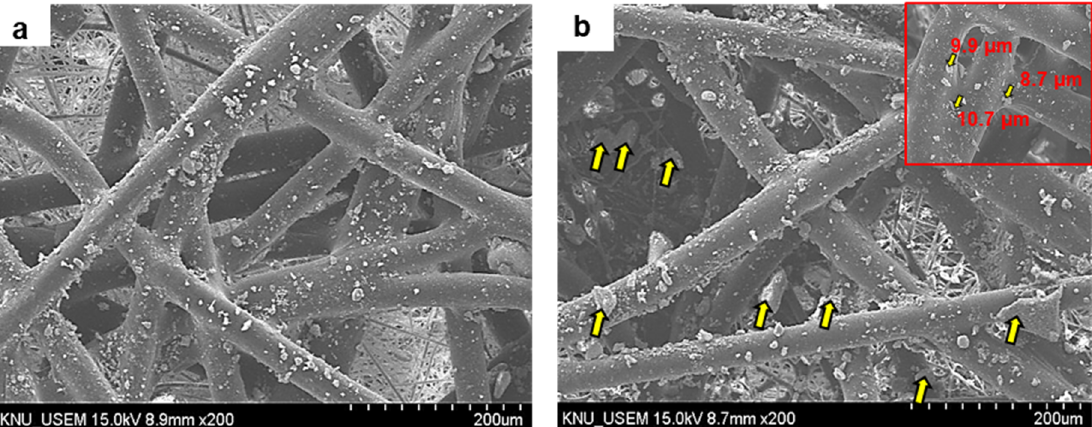
Figure 6. SEM images of ( a ) 5% PNT/NWPF before PM filtration and ( b ) 5%PNT/NWPF after PM filtration.